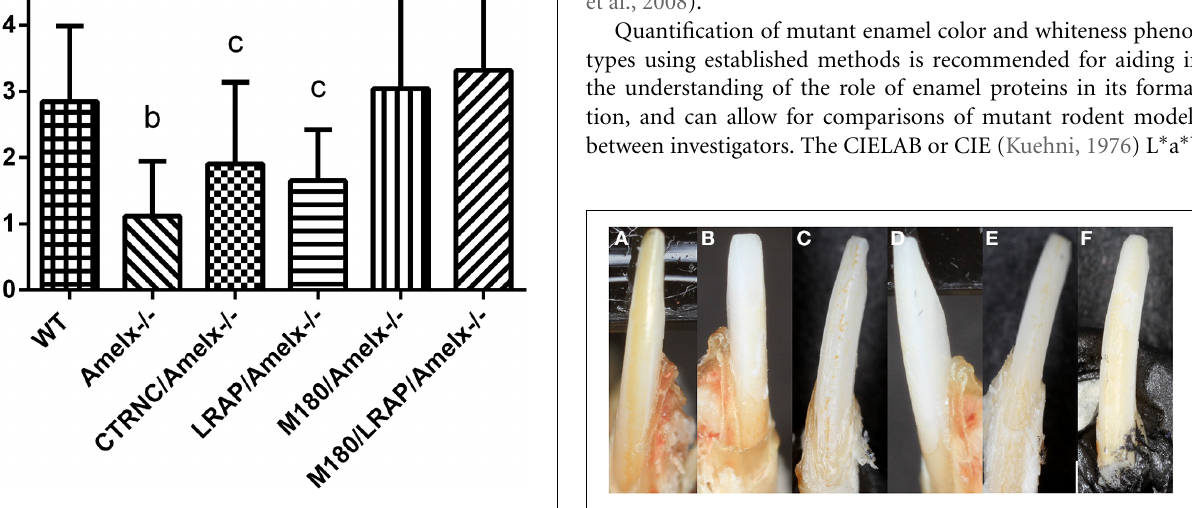
FIGURE 4 | Mouse incisor enamel pigment. (A) WT enamel has a pigment due to iron content, (B) Amelx − / − enamel is chalky white, (C) CTRNC/Amelx − / − has some improvement in pigment from Amelx − / − , (D) LRAP/Amelx − / − enamel is chalky white like Amelx − / − , (E) M180/Amelx − / − enamel has some improvement in pigment from Amelx − / − , and